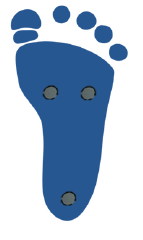
Figure 3. Placement of the pressure sensors.